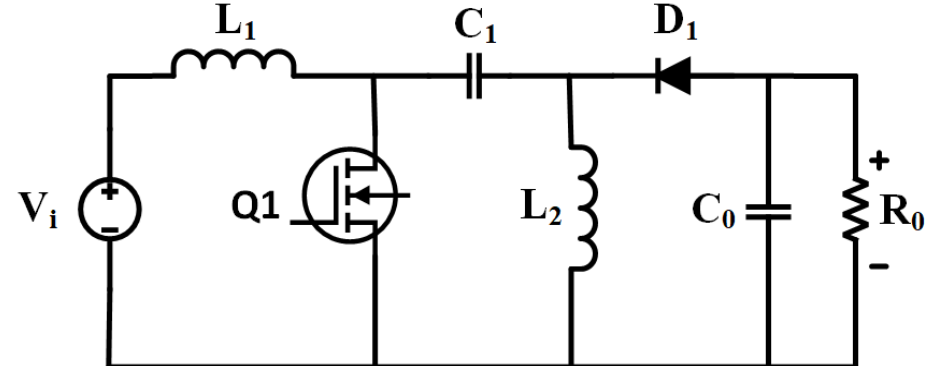
Figure 9. DC-DC SEPIC converter.